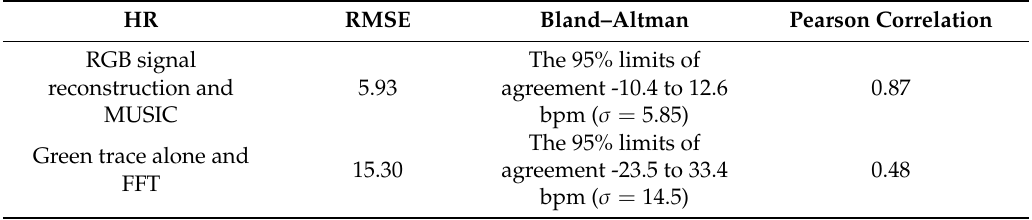
Table 1. Comparison of proposed RGB signal reconstruction method with conventional green trace method on HR measurement.